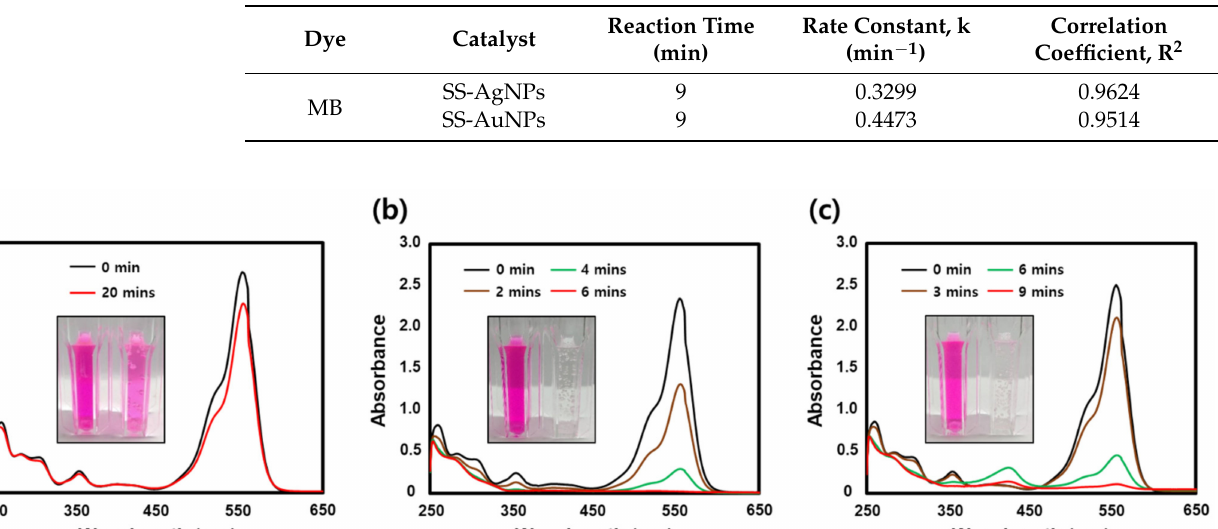
versus time during MB reduction by catalysts, ( a ) SS-AgNPs and ( b ) SS-AuNPs. Figure 8. Plot of ln A t A 0 Table 1. Values of methylene blue reduction.